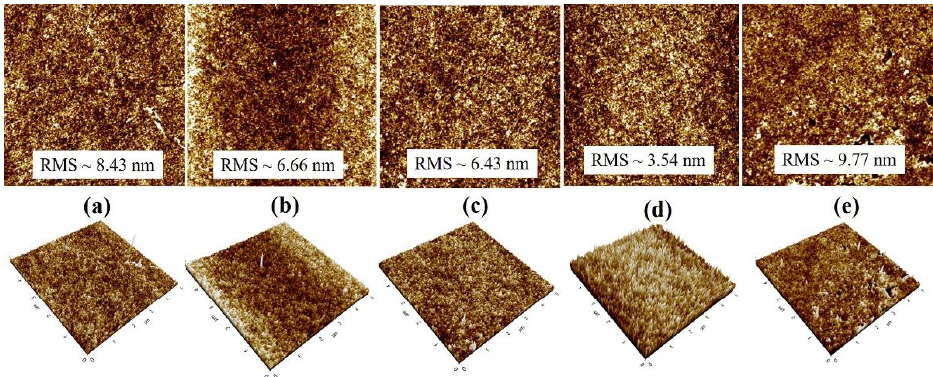
Figure 3. AFM images including topography (top images) and three-dimensional (bottom images) of ITO/PEDOT: PSS (or GO)/(FeS 2 SNPs + PBT7) films without and with hole transport buffer layers such as PEDOT: PSS and GO. ( a ) without PEDOT: PSS, ( b ) with PEDOT: PSS, ( c ) with GO (SS 1000), ( d ) with GO (SS 2000), and ( e ) with GO (SS 3000).